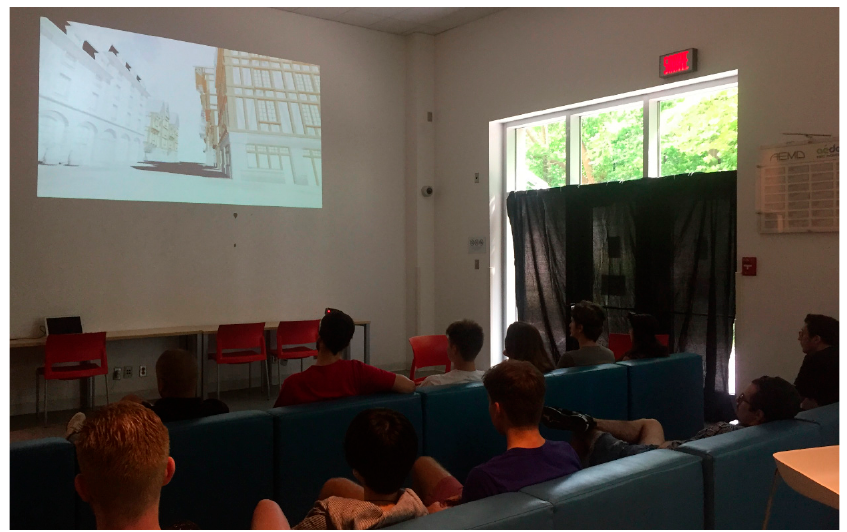
Figure 3. The projection in the collective and low-immersion setting, with 12 participants (Coll_Cont).